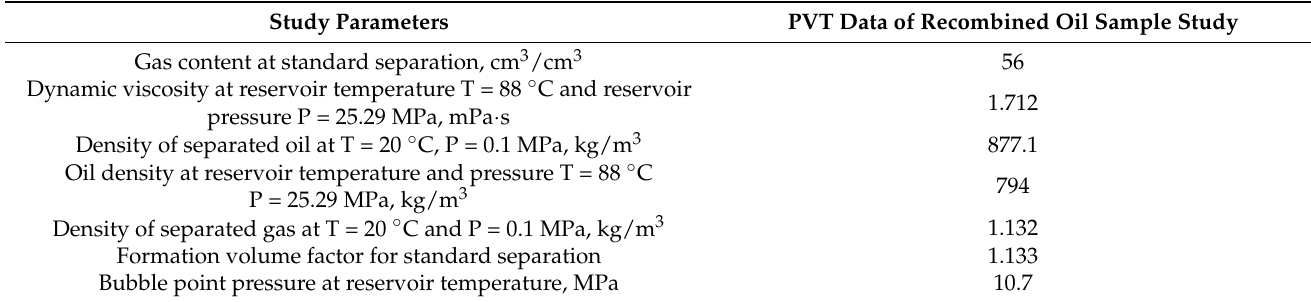
Table 1. Recombined oil properties.